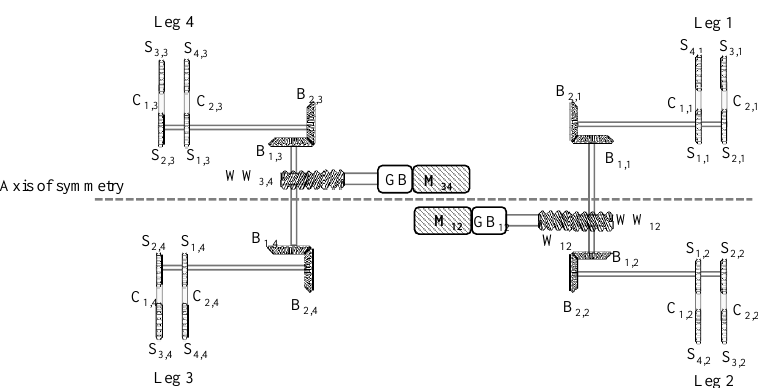
Figure 4. Line diagram of the mechanism for simultaneous abduction or adduction of the links. In the above figure W: Worm, WW: Worm Wheel, B: Bevel Gear, S: Sprocket, C: Chain, GB: Gear Box, M: Motor.